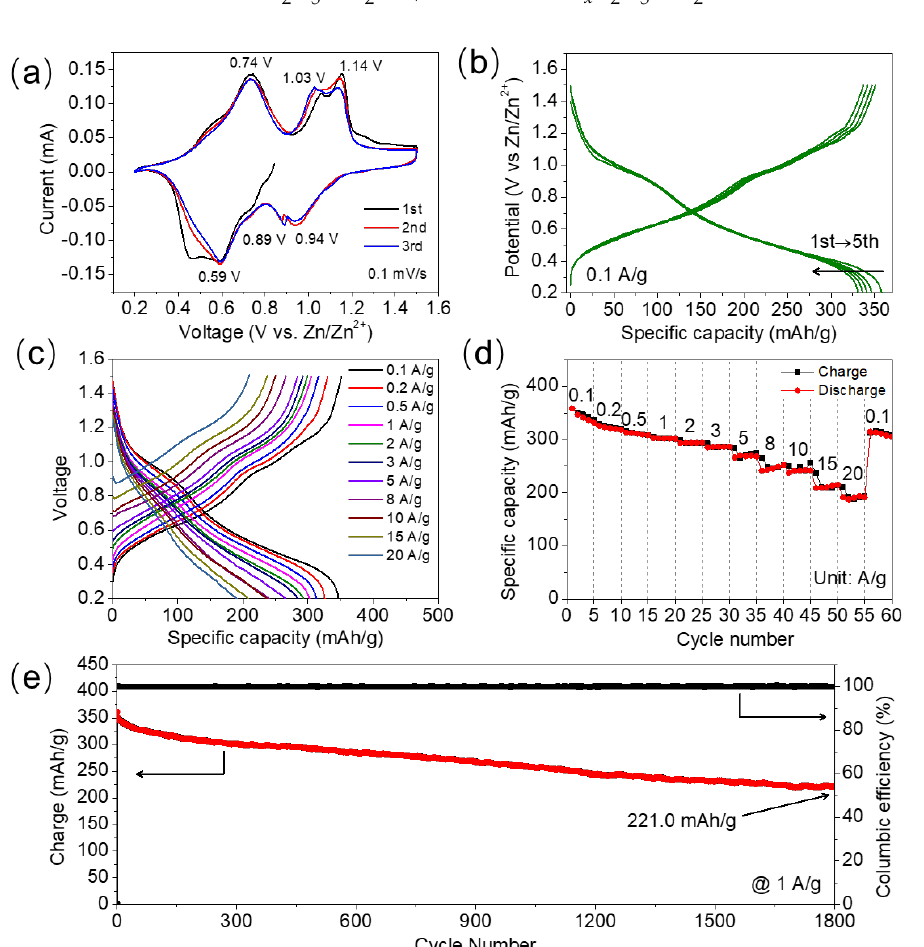
Figure 3. The electrochemical performance of hydrated V 2 O 5 . ( a ) The initial three CV curves at 0.1 mV/s, ( b ) the initial five GCD curves at 0.1 A/g, ( c ) the charging/discharging plots at current densities of 0.1 to 20 A/g, ( d ) the charging/discharging specific capacities at current densities of 0.1 to 20 A/g, and ( e ) the cycling test results for 1800 times at 1 A/g.